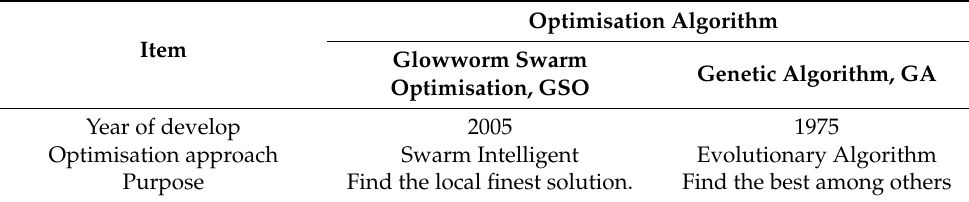
Table 1. Glowworm Swarm Optimisation (GSO) and Genetic Algorithm (GA)